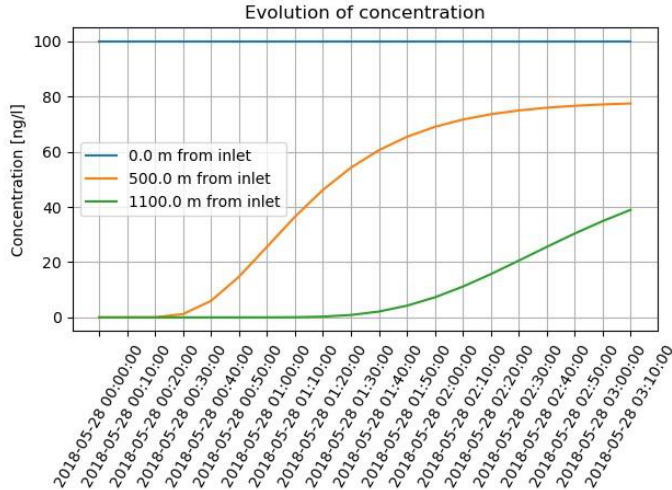
Figure 8. C 0 mass injection, constant over time: concentration values at selected points of the reach.